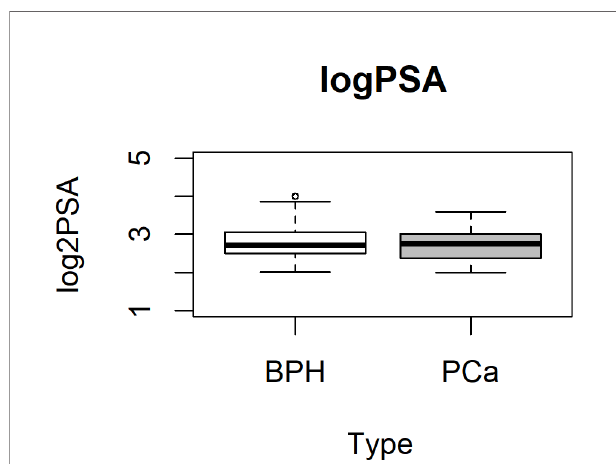
FIGURE 2 | PSA boxplot in BPH and PCa groups. Box plot showing the strati fi cation of samples into the BPH (white box) or PCa (gray box) group.